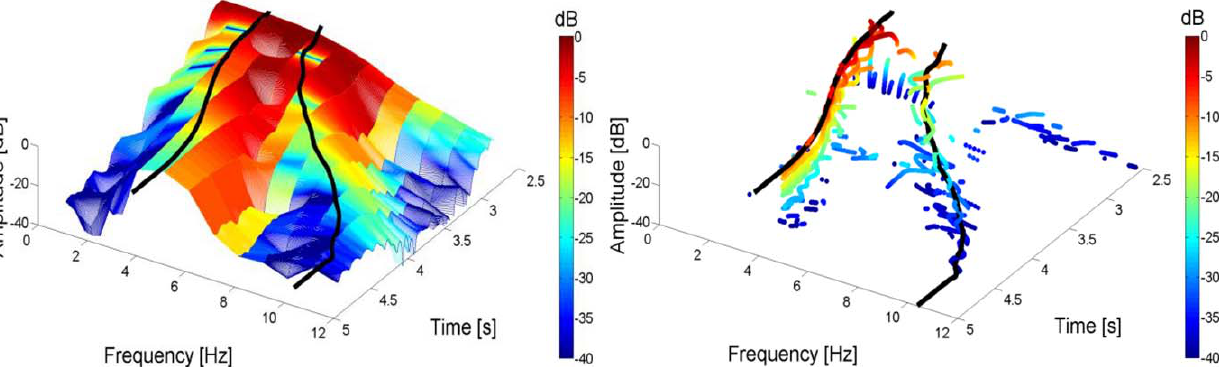
Figure 5. Example of Spectrograms. Short Time Fourier Transform (STFT) Spectrogram on the left and Reassigned Spectrogram (RS) on the right for a simulated arm reaching movement with sigmoidal joint stiffness. Based on the classical spectrogram, the partial derivatives of the STFT phase with respect to time and frequency were calculated. This process identifies the location of the stationary phase with respect to the location of the window in the time and frequency domain. The time delay and frequency shift obtained with this process are then used to ‘‘reassign’ the position of maximum energy. Savitzky-Golay polynomial filtering allows for easy calculation of the RS peaks envelope. The envelope is depicted in both the classical and reassigned spectrogram in black. Note that it would be difficult to estimate accurately the peaks’ envelope in the classical spectrogram due to the lower frequency accuracy.